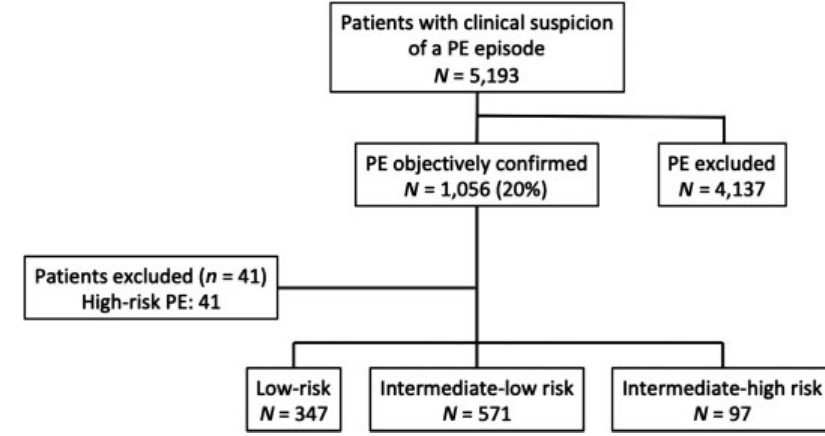
Fig. 1 Patient fl ow diagram. PE, pulmonary